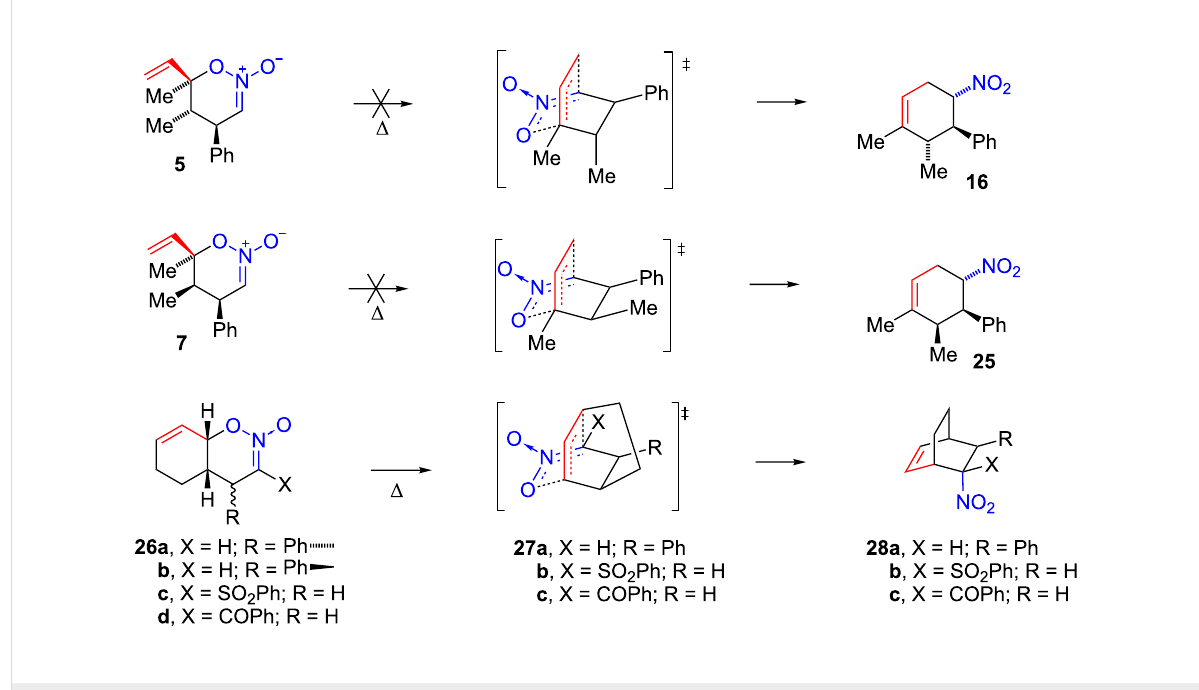
Scheme 5: Thermal reactions of nitronic esters 5 , 7 , and 26a–d .